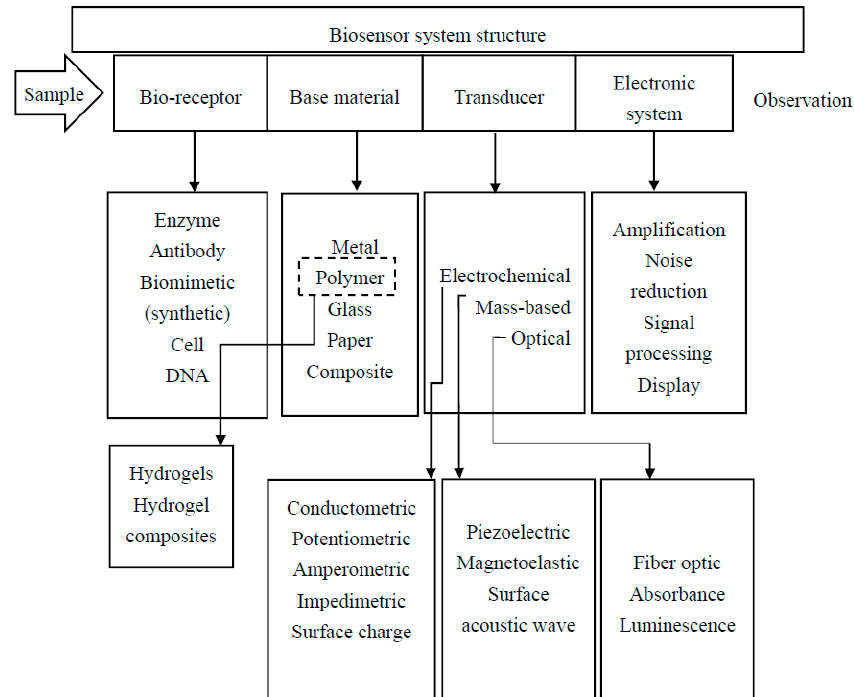
Figure 1. A typical biosensor system includes structural elements, materials, and strategies for sensing. Hydrogel, as a biocompatible polymer with great ability of water absorption, can be used as a base material to form a hydrogel based biosensor. Some sensing strategies (electrochemical, mass based, and optical) can be used for identification of a specific biomolecule using mentioned measurement methods (conductometric, potentiometric, amperometric, impedimetric, surface charge, piezoelectric, megnetoelastic, surface acoustic wave, fiber optic, absorbance, and luminescence). Measurement methods are not limited to the mentioned methods explained here and other classification (i.e., label based vs. label-free) can be noticed as well.